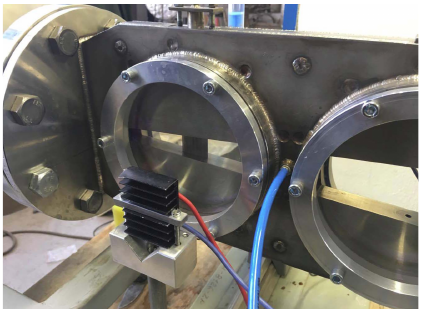
Fig. 1. Wind tunnel test section.